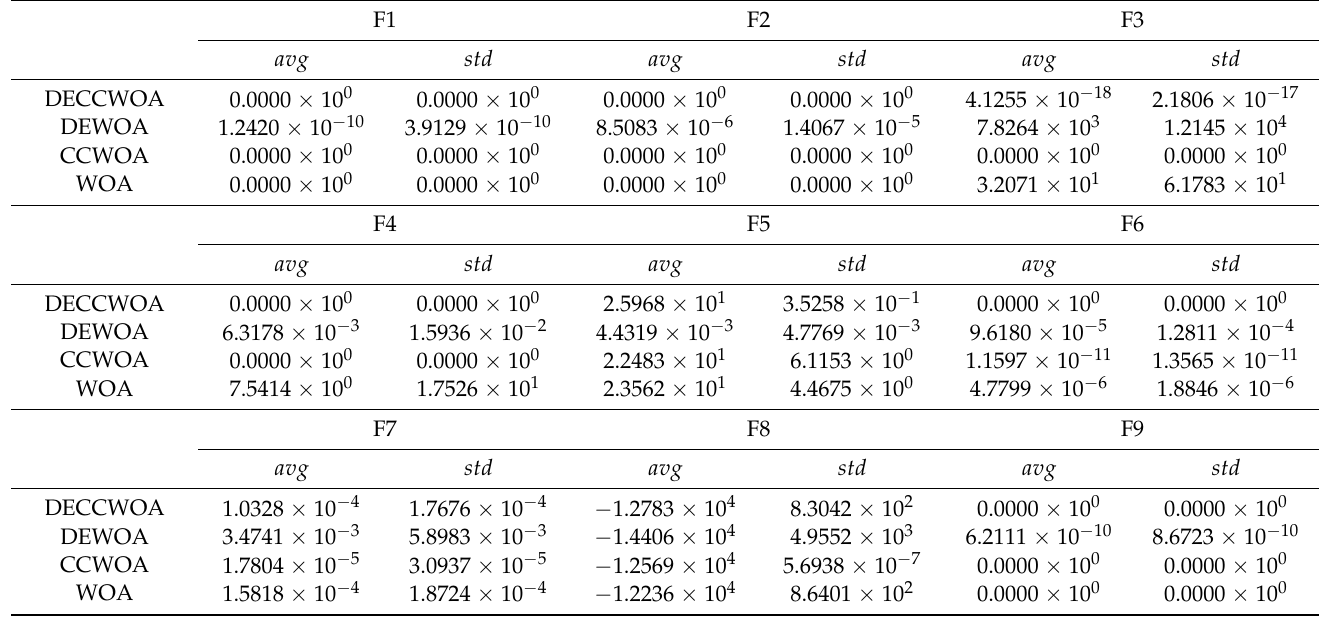
Table A3. Comparison results for the introduced